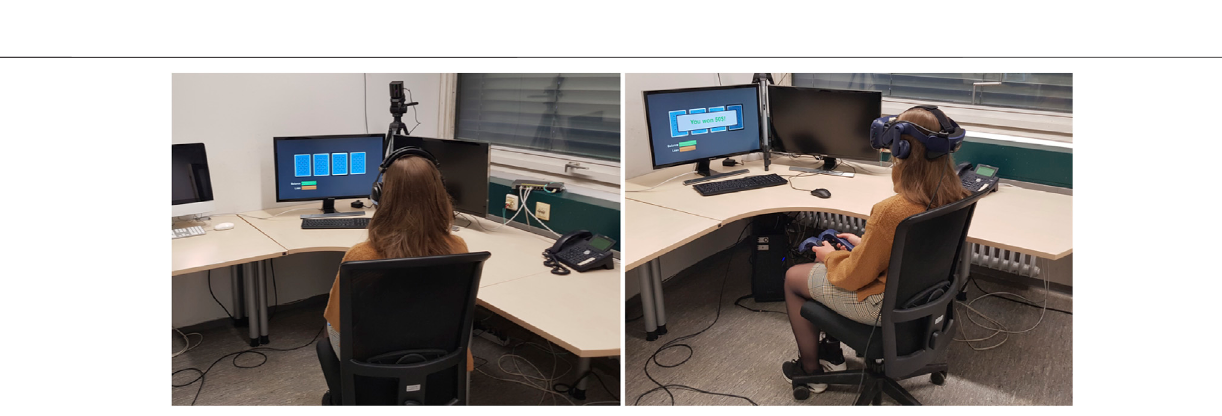
FIGURE 5 | We matched the position of the virtual screens with the physical screen. In all conditions, participants sat at a distance of 1.3 m away from the screen. Left: Participant plays the desktop version. Right: Participant completes a VR version of the IGT.